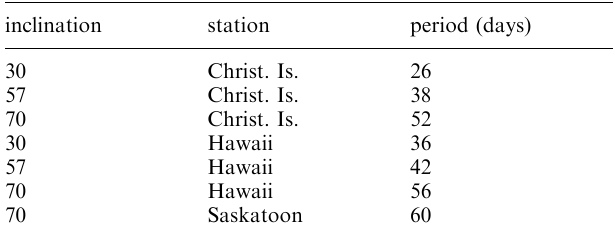
Table 1. Precession periods for 24-h local time (ascending & descending nodes) inclination